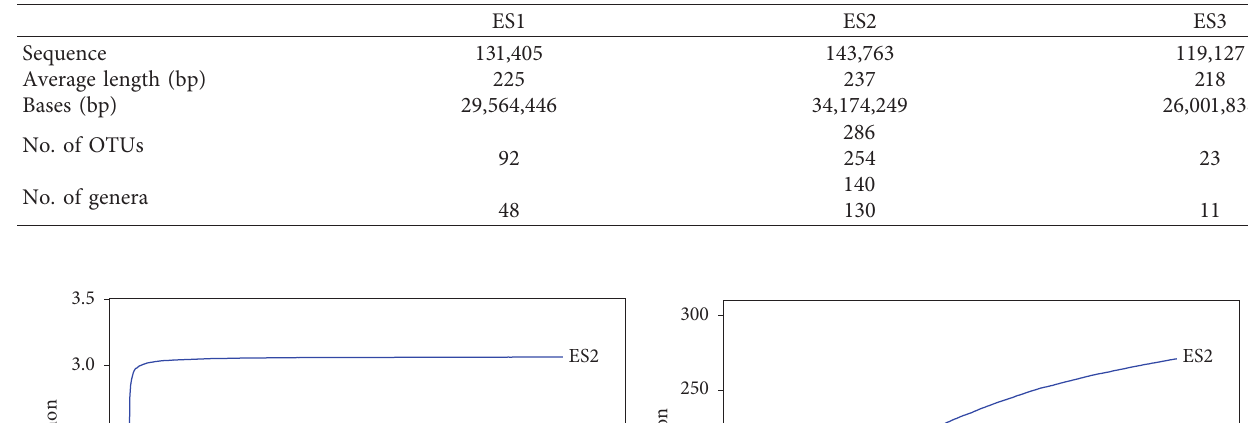
Table 1: Summary of HTS of the ITS1 amplicon for E. sinensis .